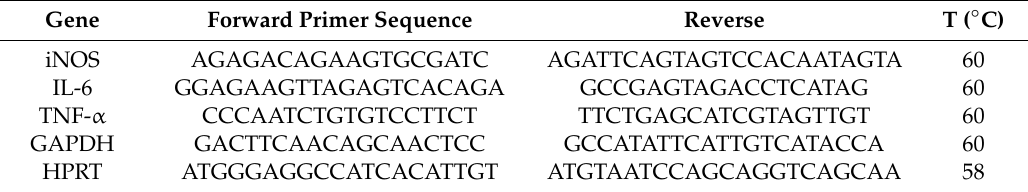
Table 1. Primer sequence used for the RT-PCR